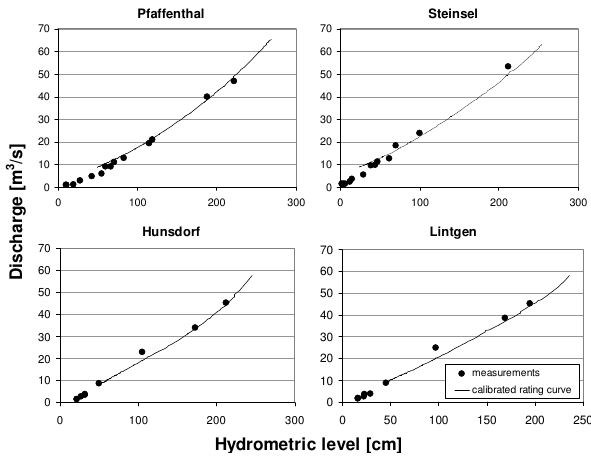
Fig. 7. Calibrated rating curves for the cross sections with available discharge